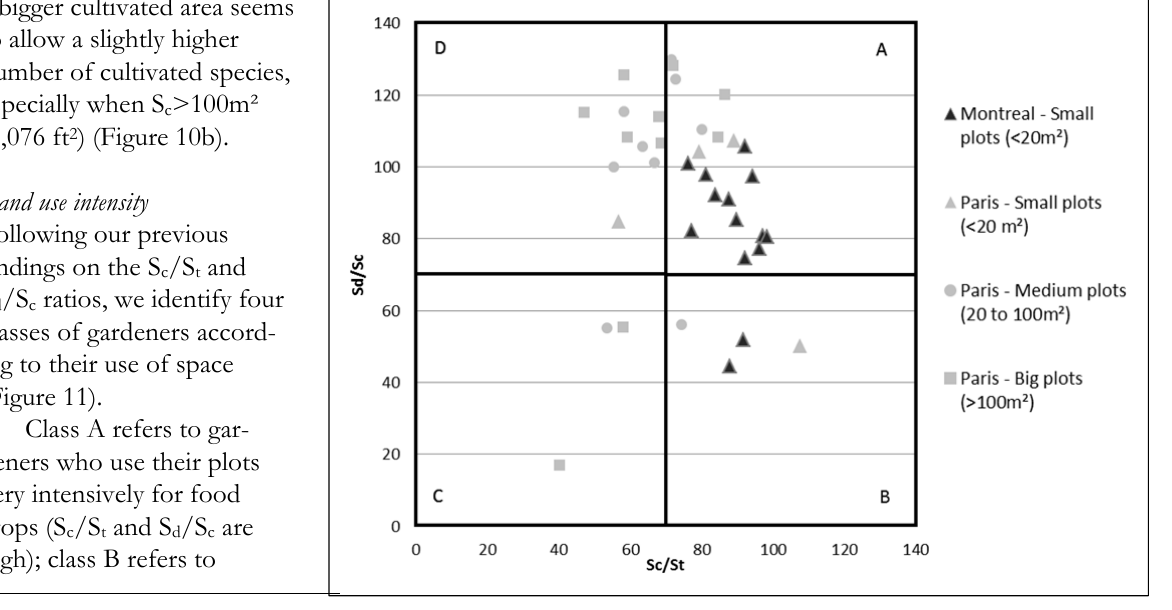
Figure 10a. Crop Diversity by Cultivated Surface, for Paris and Montreal